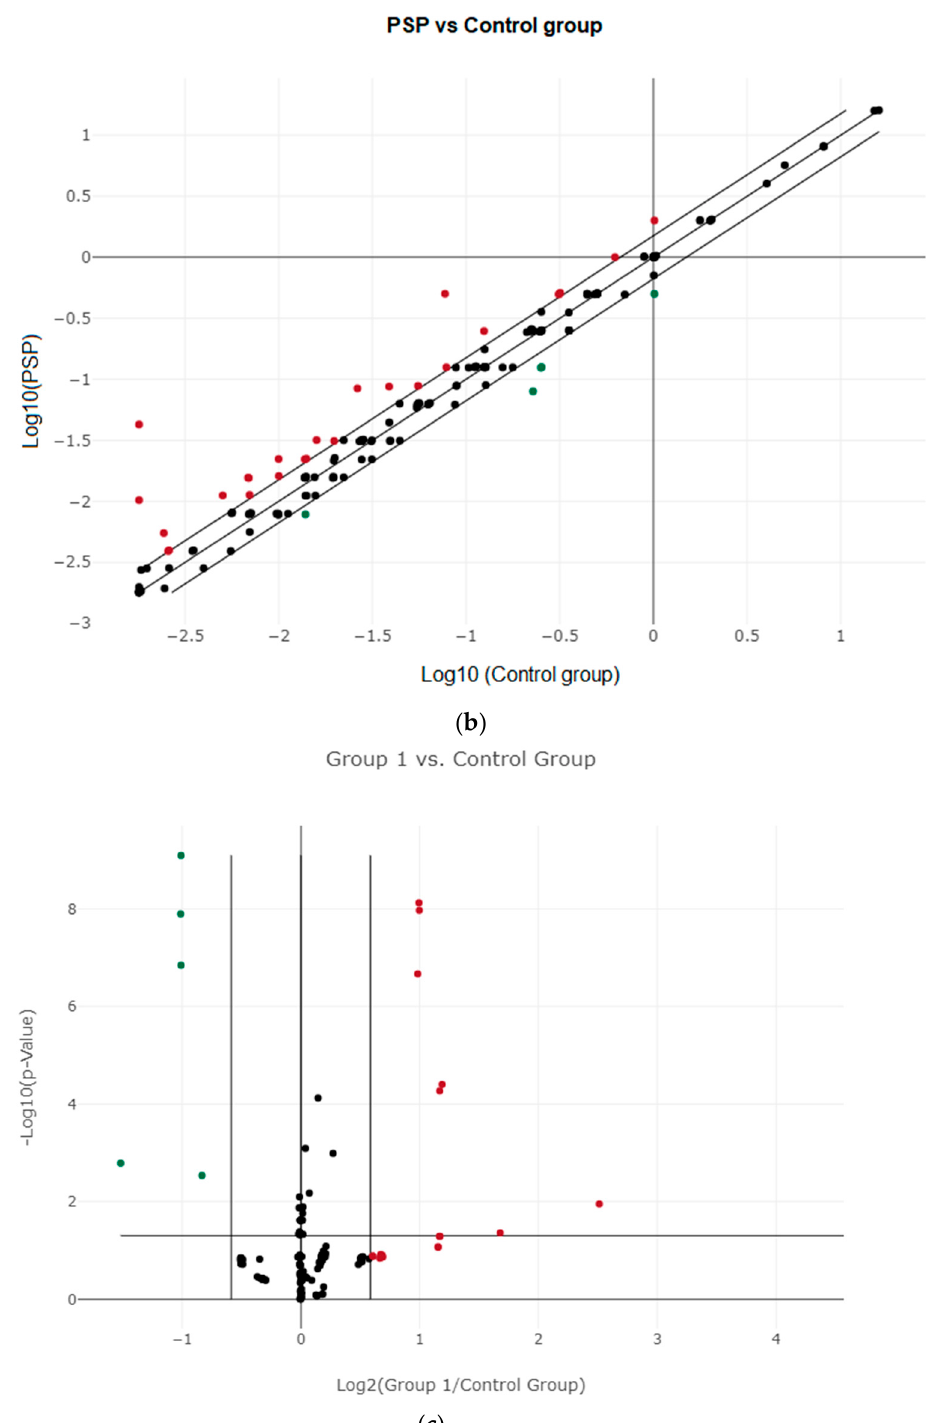
Figure 1. ( a ) Principal component analysis (PCA) plot. Blue-colored dots are control samples and orange-colored dots are PSP. ( b ) Scatter Plot of differentially expressed miRNAs. The up-regulated miRNAs are displayed in red, and down-regulated miRNAs are displayed in green. ( c ) Volcano plot. Red-colored dots represent overexpressed miRNAs, green-colored dots represent downregulated miRNAs compared to control, and black dots are insignificant miRNAs analyzed.